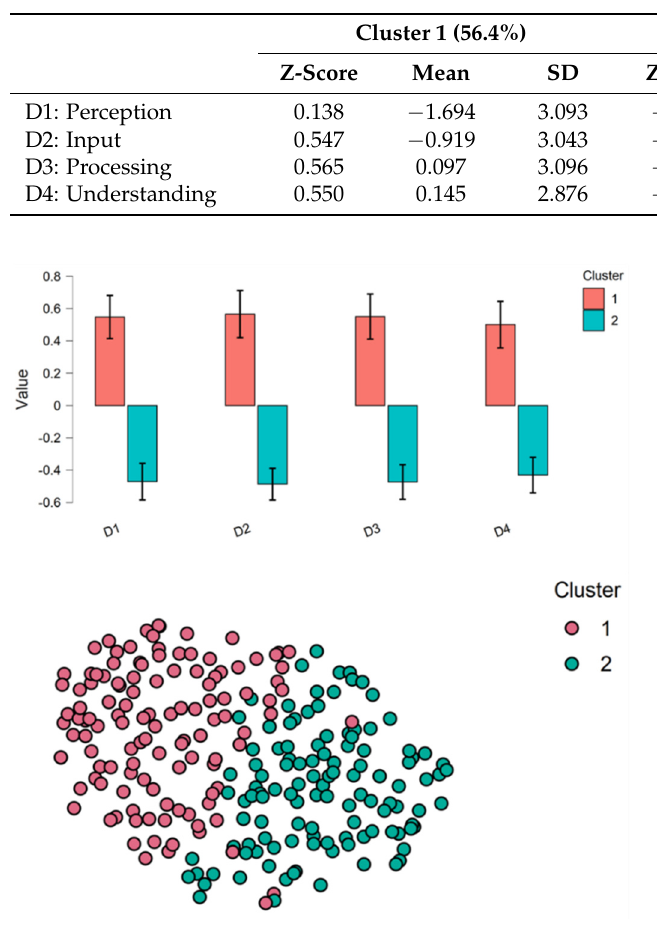
Table 2. Results of k-means clustering analysis.